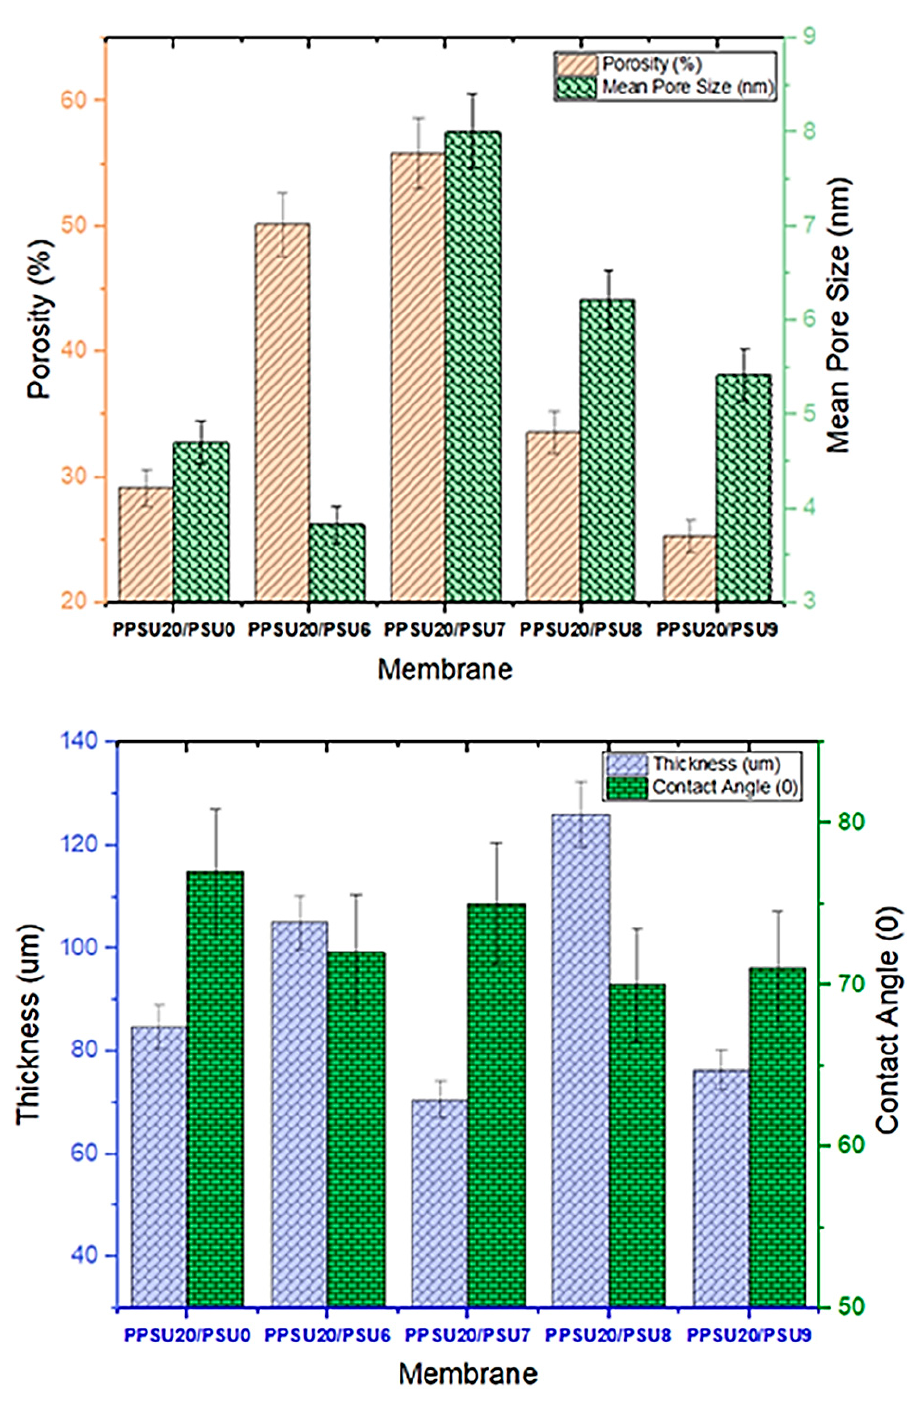
Figure 5. characteristics of the membranes. Porosity and mean pore size ( Top ), and membrane thickness and CA ( Bot ‐ tom ). thickness and CA ( Bottom